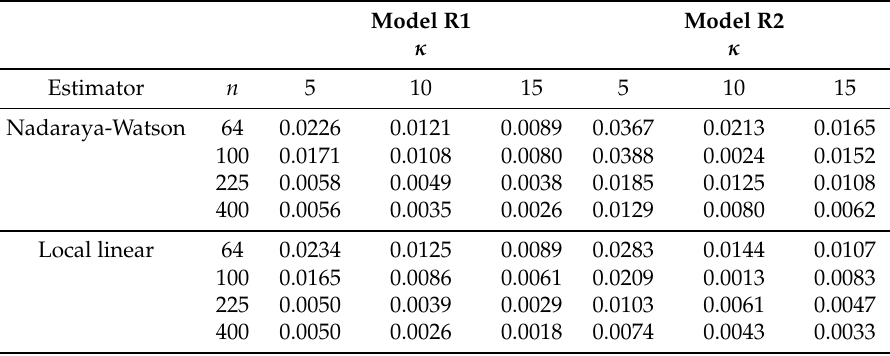
Table 1. Means of errors 1 using Nadaraya-Watson and local linear